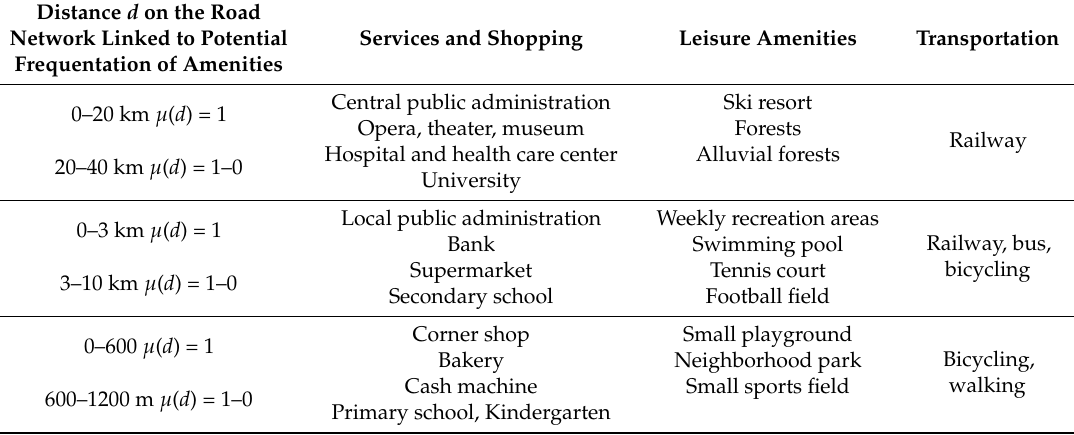
Table 2. Sample types and potential frequentation, including distance function as used for this sample